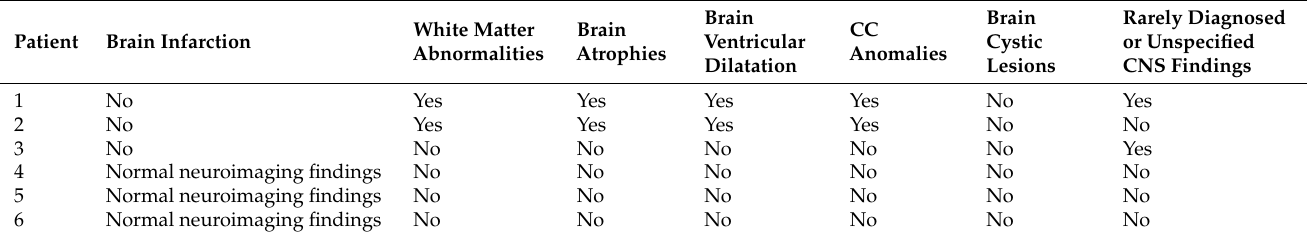
Table 3. Different CNS findings diagnosed using MRI.